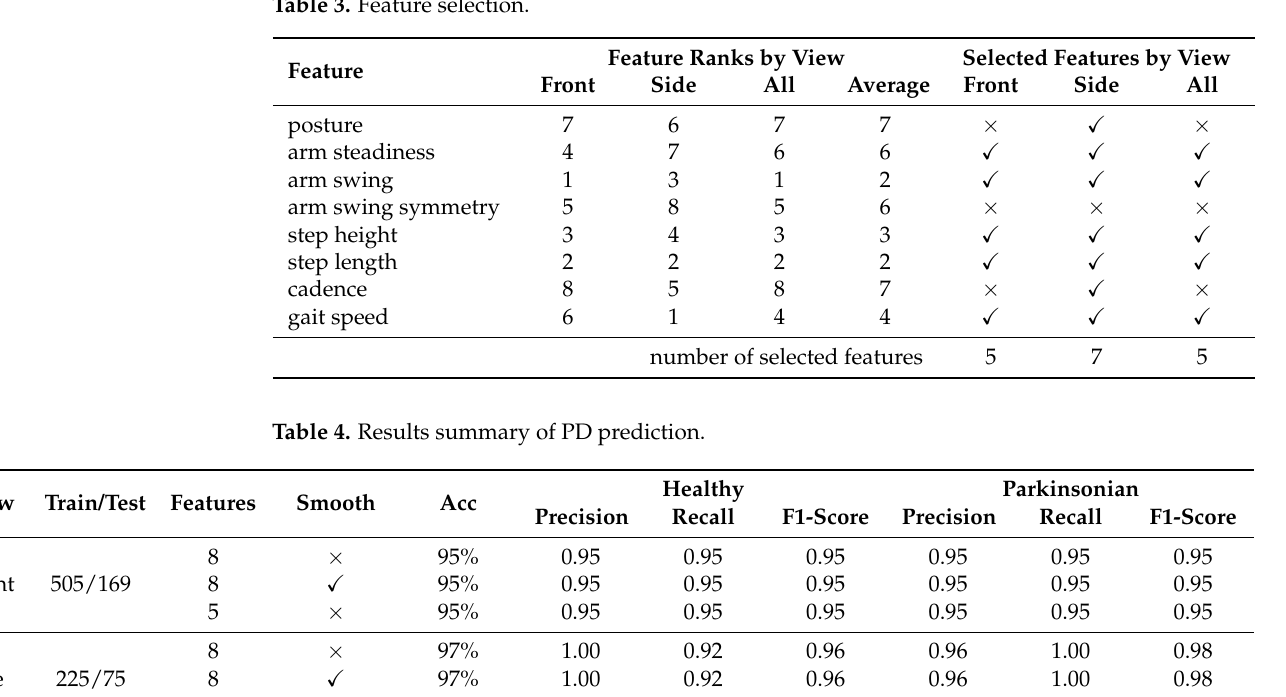
Table 3. Feature selection.